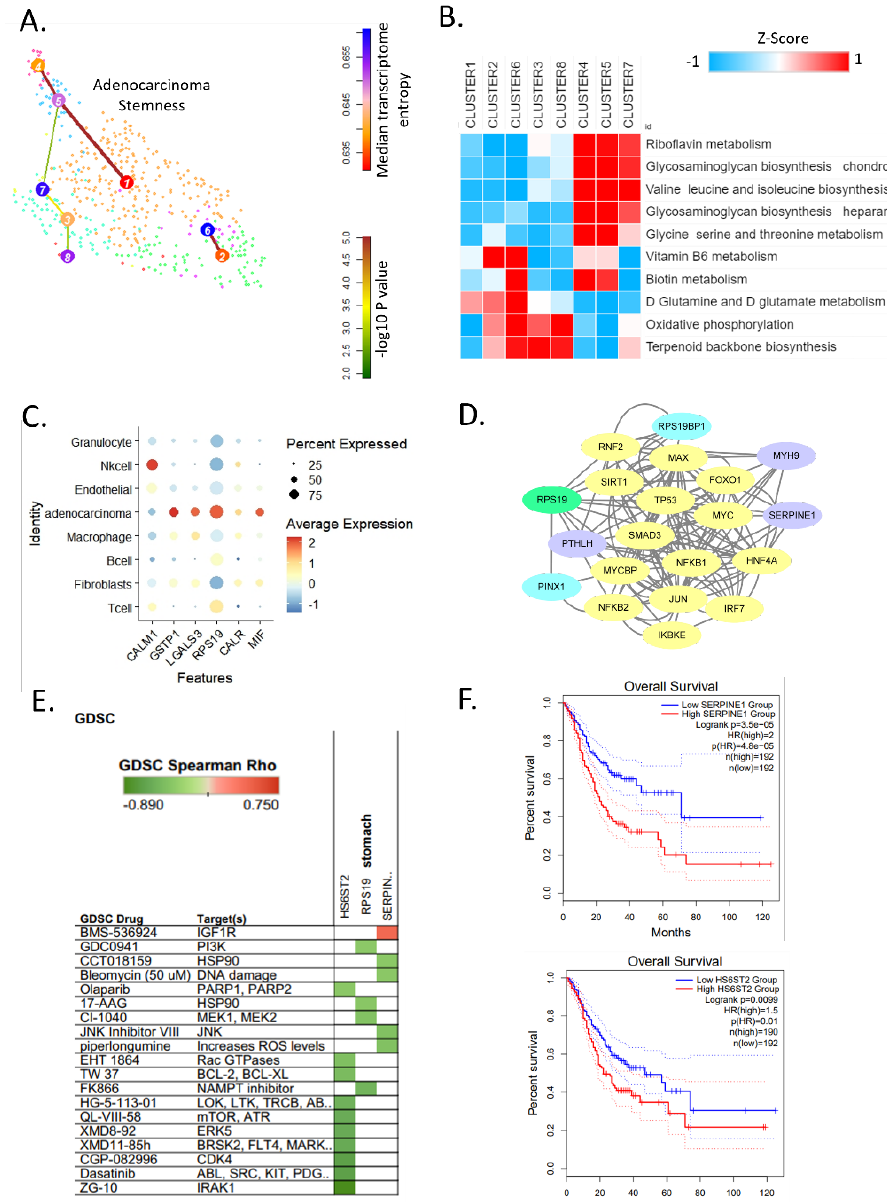
Figure 4. Metabolic heterogeneity and stem cell identification and cell–cell interaction correlates with therapeutic sensitivity. ( A ) RaceID3 and StemID2 analysis of 924 adenocarcinoma cells from the original clusters. The link color indicates the link p -value, and the vertex color represents transcriptome entropy. The link p -value and transcriptome entropies were derived by StemID2. The thickness and color of a link indicate the transition probability between the connected clusters. ( B ) Heat map of enriched metabolic pathway for adenocarcinoma clusters. ( C ) Dot plot of best upstream ligands for eight cell types. ( D ) Signaling path for the RPS19 ligand and the target gene link. ( E ) Genomics of Drug Sensitivity in Cancer (GDSC) drug and target genes for gastric cancer. Green (negative correlation) indicates high drug sensitivity ( F ) Kaplan–Meier plot showing recurrence-free survival rates for high and low SERPINE1 expression in gastric cancer of TCGA cohort (up) and HS6ST2